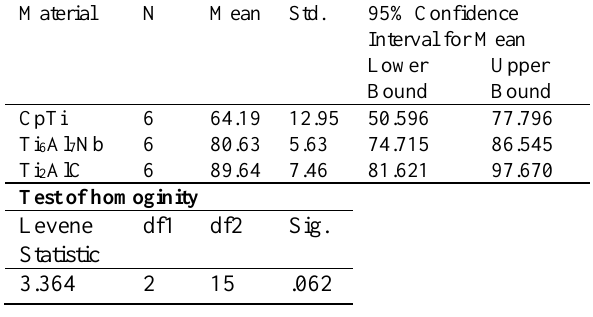
Figure (1) Microscopic view for different examined materials at (2 & 6 weeks) where basal bone (BB), few scattered bone trabeculae (BT), Osteoid tissue (OST), Osteoblast (arrows).